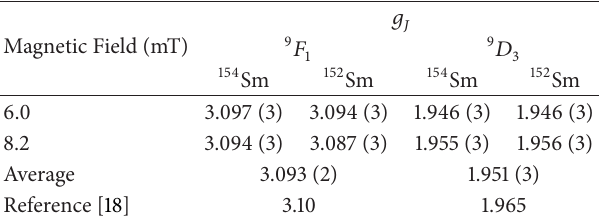
Figure 4: Zeeman splittings and transitions for the 680.30 nm transition. 𝑚 𝐽 is the magnetic quantum number and Zeeman transitions are divided into the three series of Δ𝑚 𝐽 = −1, 0, +1 . The numbers on the Zeeman transitions correspond to the numbers labeled on peaks in Figure 3. Table2:DeterminedatomicLand´e g -factors, 𝑔 𝐽 ,forthe4 f 6 6 s 6 p 9 𝐹 1 and 9 𝐷 3 levels in Sm I together with the reference